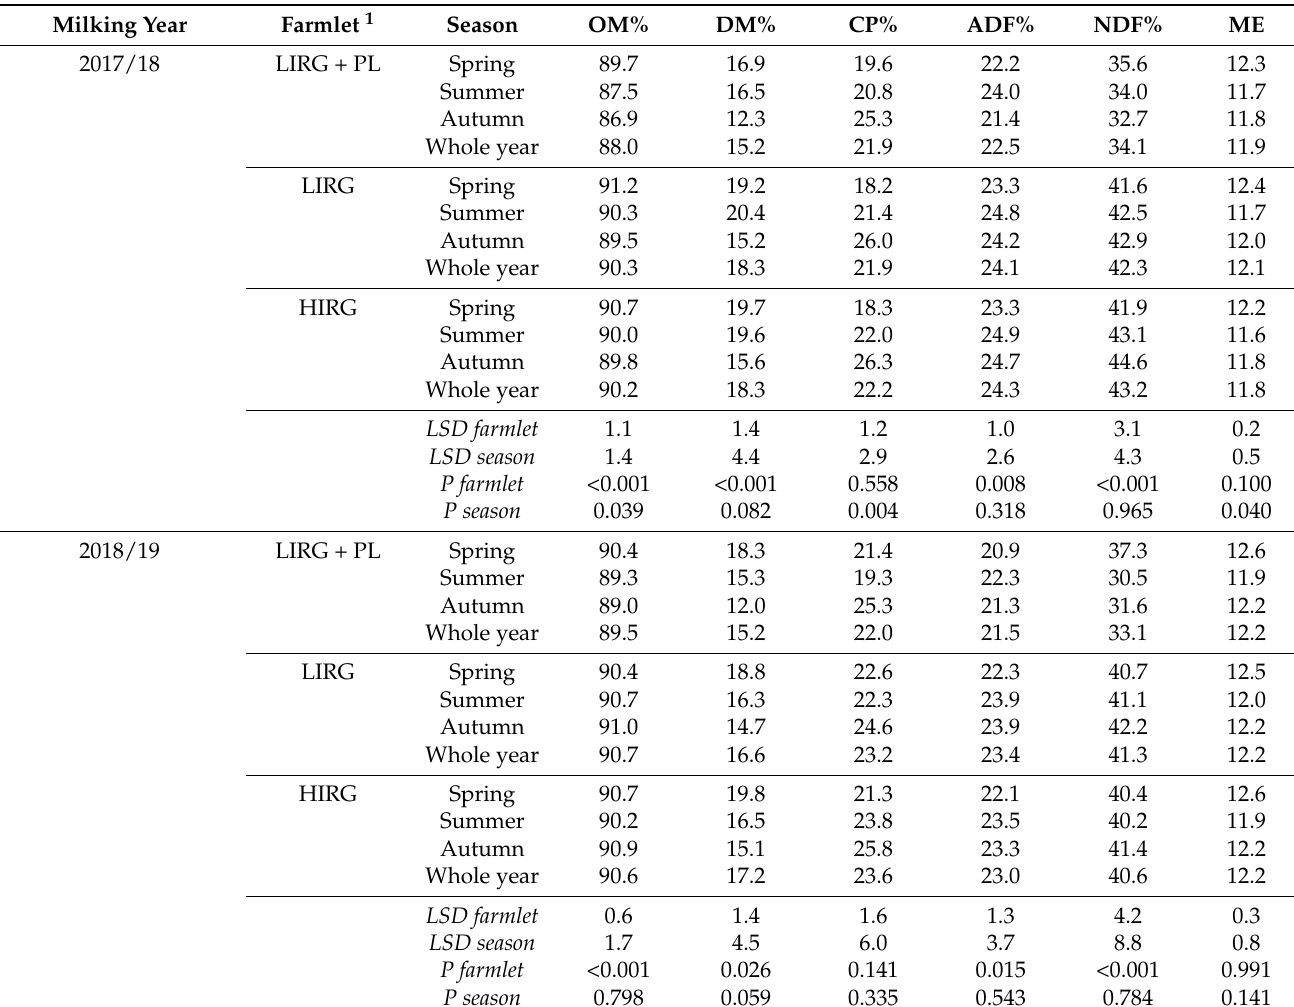
For variables describing the composition of the diet (DM%, OM%, ADF%, NDF%, CP%, ME), the fixed factors of the model consisted of treatment, season, and the interaction term, along with paddock that the samples were collected from as a random factor (see Table 2). For the response variables related to milk production per cow (yield, MS, Fat%, Protein%), the mean values for each cow over each month were used as the response variables, and the fitted models included treatment and month as fixed explanatory factors, along with the interaction term, and individual cows included as a random factor (Table 4). This same model structure was also used for variables that described feed intake per cow, such as herbage intake and total DMI (Figure 2 and Table 3). For LW and BCS, the model included treatment and stage of lactation, and the interaction term, as fixed factors, and individual cows as a random factor (Table 4). Table 2. Dry matter (DM) %, organic matter (OM), crude protein (CP), acid detergent fibre (ADF) and neutral detergent fibre (NDF) % in DM, and metabolisable energy (MJ/kg DM) of herbage grazed by cows during spring, summer, and autumn in 2017/18 and 2018/19 milking year. Farmlet